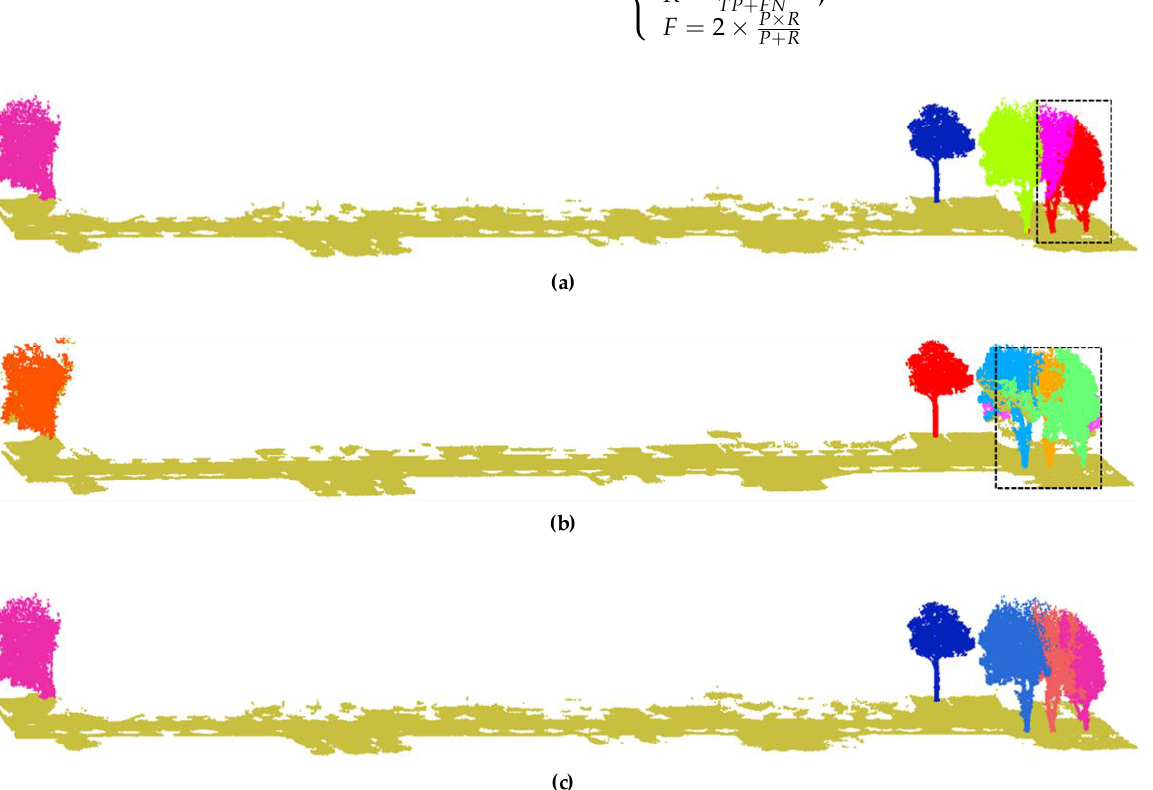
Figure 13. Comparison results in Scene 2. ( a ) Clustering based method [44]. ( b ) 3D Forest method [30]. ( c ) Our method.